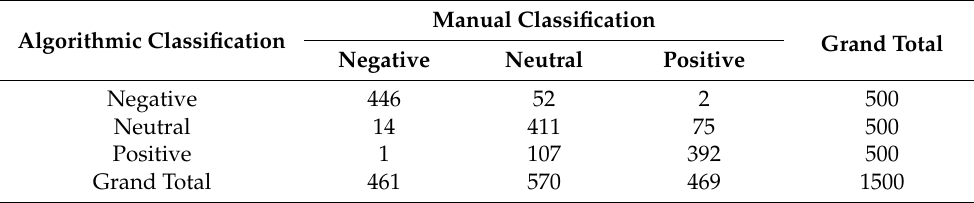
Table 4. Validation of combined sentiment classification.